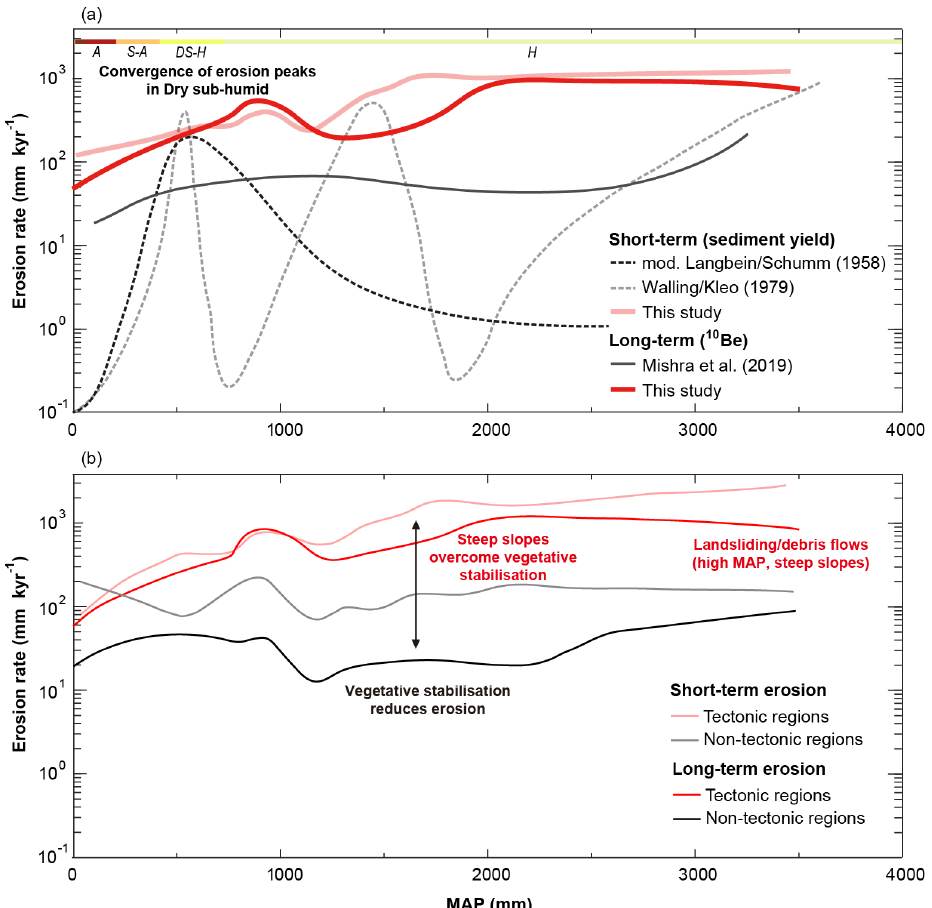
Figure 11. (a) Synthesis of non-linear relationships between MAP and short-term erosion rates (modified Langbein and Schumm, 1958 (see text), Walling and Kleo, 1979, and this study) and between MAP and long-term erosion rates (Mishra et al., 2019, and this study). (b) Relationships between short- and long-term erosion rates and MAP classified between tectonic and non-tectonic regions. MAP precipitation regimes akin to Aridity Index classes are shown along the top. The figure highlights the convergence of erosion peaks in Semi-arid and Dry sub-humid